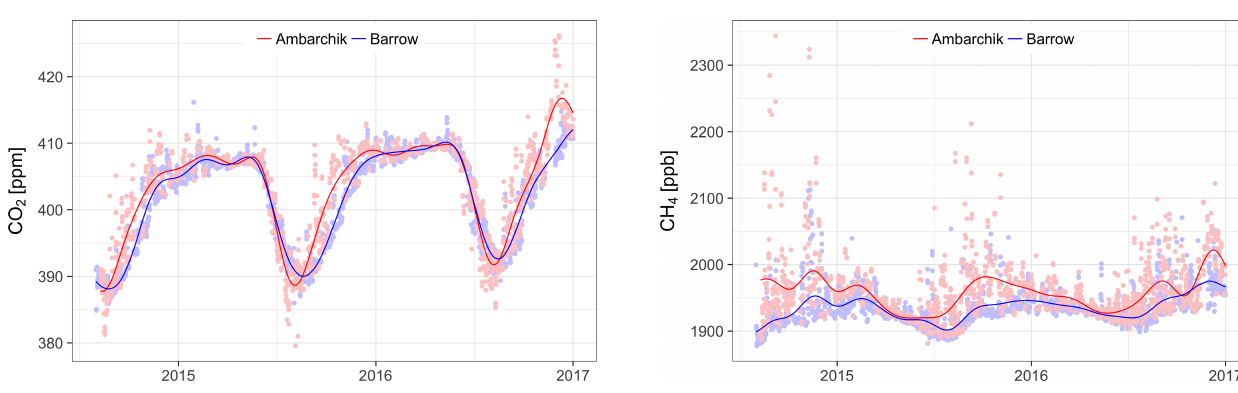
Figure 9. Same as Fig. 8, but for CH 4